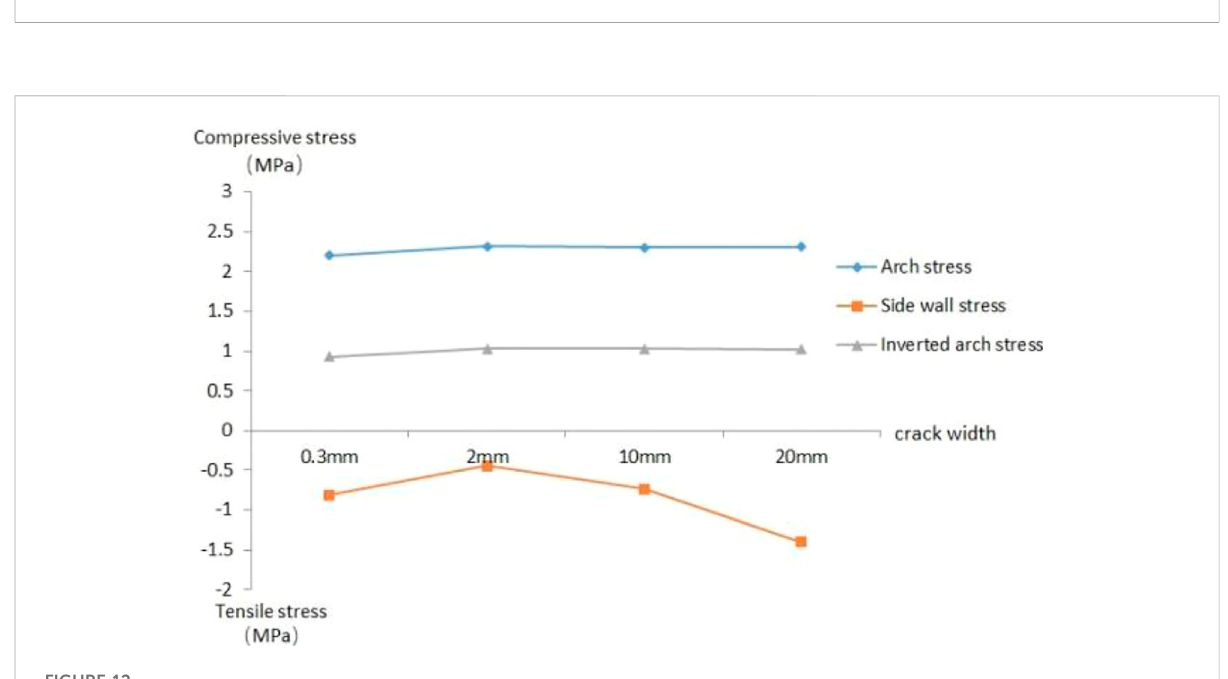
FIGURE 12 Stress variation diagram of main position of cracked lining of side wall